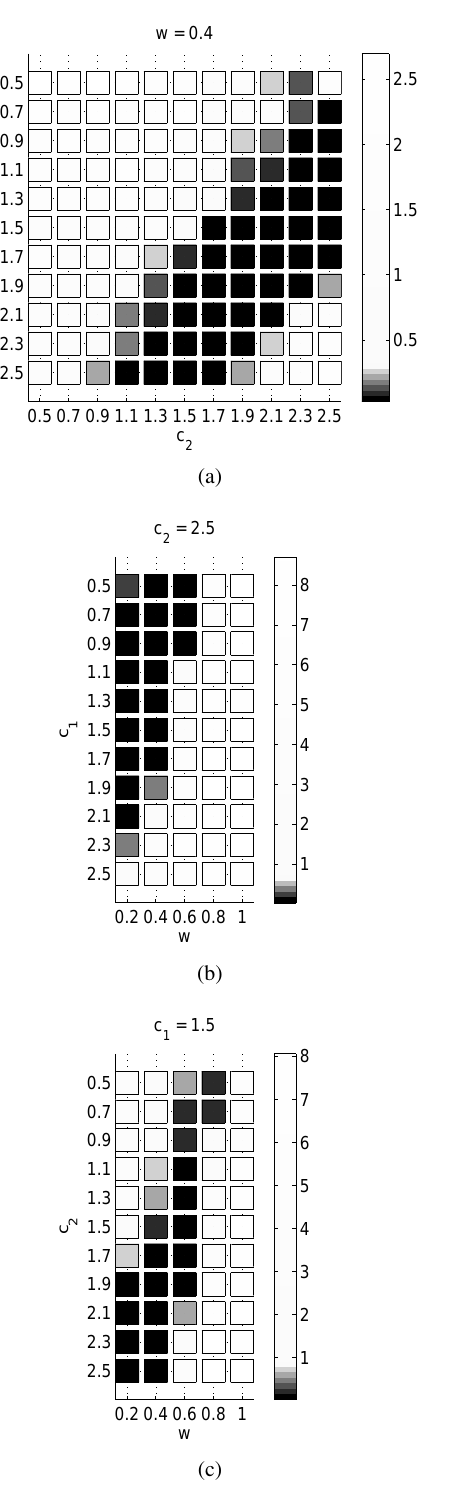
Fig. 2: Dependence of the objective function value on the Fig. 2. Dependence of the objective function value on the number of different parameters of PSO complexes p and the number of inner loop iterations nI of SCE-UA.